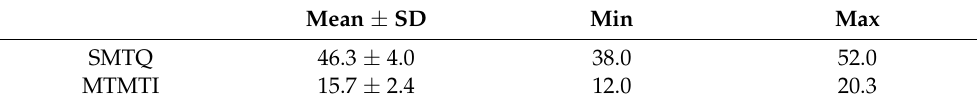
Table 3. Descriptive Statistics—MT Psychological Component Instruments and MT Levels.